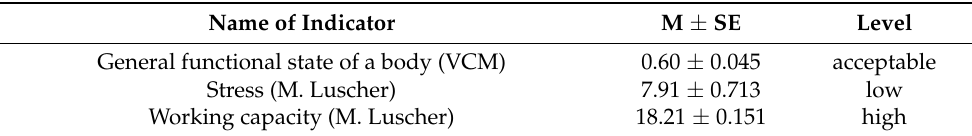
Table 3. Mean values and standard errors of the average general functional state of body, stress and working capacity of